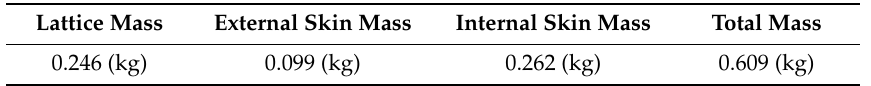
Table 2. Test case 1—Mass budget.